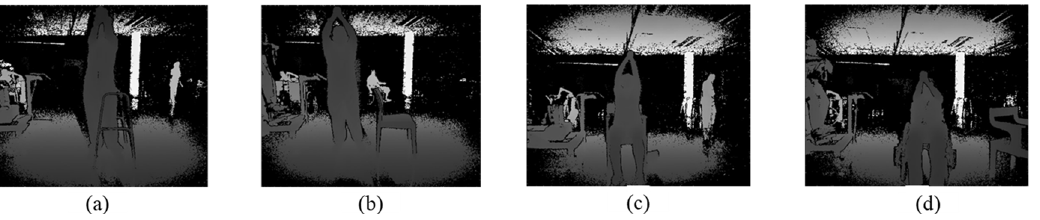
Figure 1. Frames showing patients during SFE gesture in all 4 positions: ( a ) standing using a